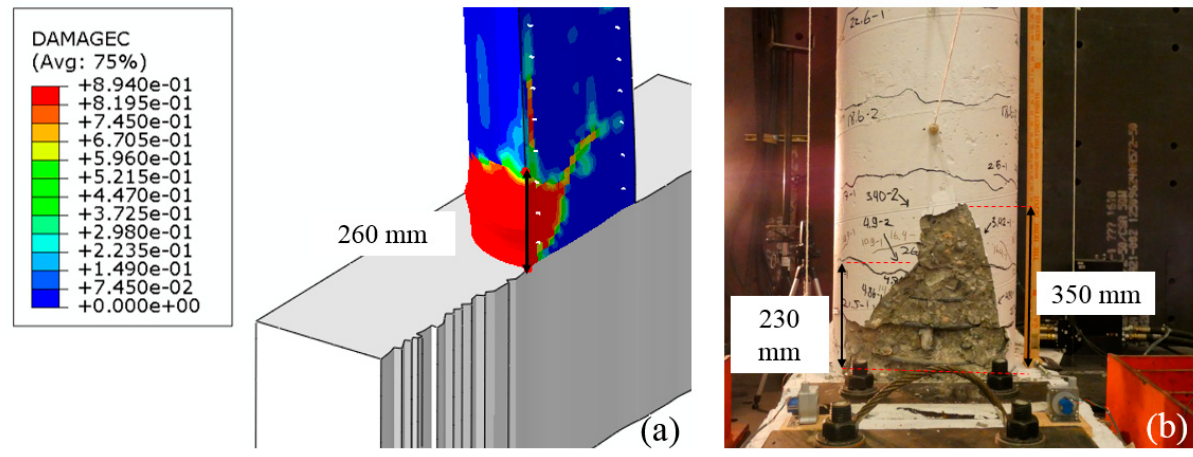
Figure 16. Comparison of ( a ) compressive damage from the FE model with ( b ) spalling in the experiment.